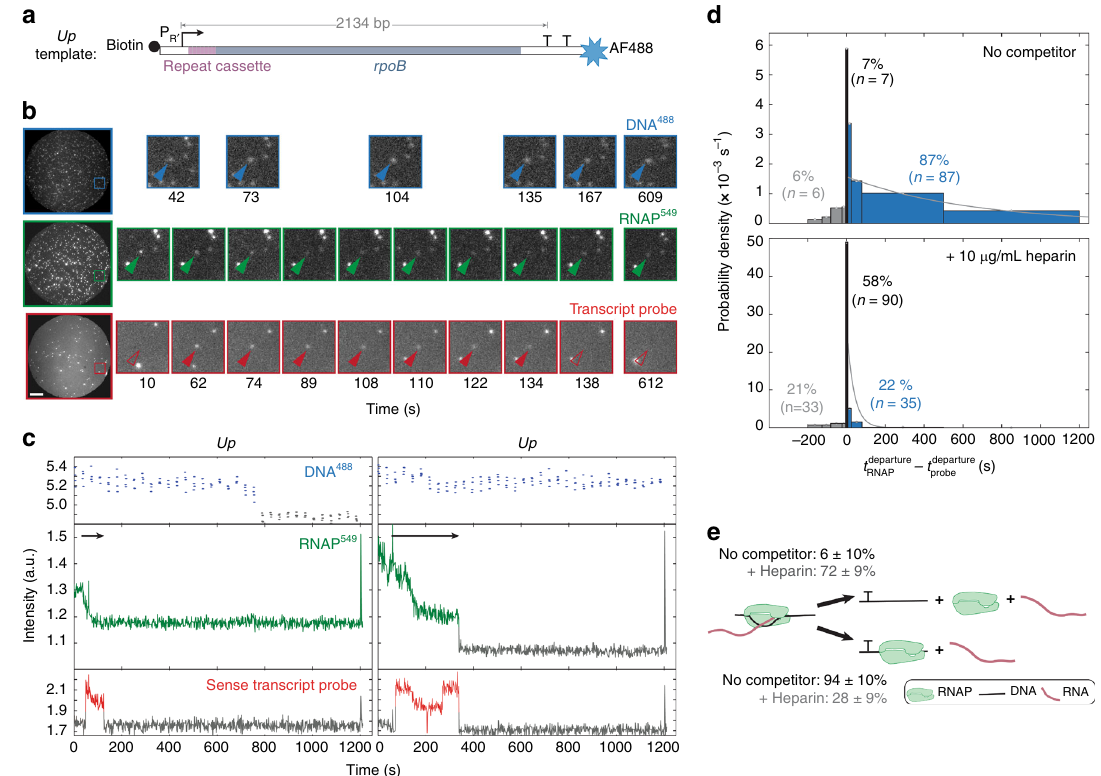
Fig. 1 RNAP usually remains bound to the DNA template following transcript release at an intrinsic terminator. a Up transcription template. The template contains a wild type λ P R´ promoter region (bent arrow) followed by seven tandem repeats of a 21 bp cassette (maroon), a partial sequence of E. coli rpoB coding region (gray) and two consecutive intrinsic terminators (T): λ T fi ciencies in vitro of 93-95% and R ʹ and T7 T E , which have termination ef 88 ± 2%, respectively 59 – 61 . Biotin is positioned upstream ( “ up ” ) of promoter so that RNAP moves away from the streptavidin-coated slide during transcription. b Left: Images (65 × 65 µ m) of the same microscope fi eld of view of DNA 488 (blue), RNAP 549 (green) and Cy5-transcript hybridization probe (red). Right: magni fi ed views of the marked regions at various times during the experiment; NTPs were introduced at time t ~ − 10 s. Blue arrows mark the location of a DNA spot, green and red arrows mark the surface location in the other images, with presence ( fi lled arrows) and absence (open arrows) of a co-localized fl uorescence spot indicated. Scale bar, 10 µ m. c Example fl uorescence emission records from the locations of two DNA spots from the same experiment. Gray color marks intervals during which no fl uorescent spot was seen. Arrows mark intervals of transcript elongation. Left: RNAP remains after probe departs (data from marked molecule in ( b )) Right: RNAP and probe depart simultaneously. d Normalized histogram of RNAP 549 departure time relative to Cy5-transcript probe departure from the same DNA spot for elongation reactions in the absence and presence of heparin. RNAP 549 spot departed either before (gray), within 4 s of (black), or after (blue) transcript probe spot departure. The 4 s threshold was chosen because it is the maximum interval between consecutive frames. Gray curves are single exponential fi ts to the RNAP departure times following probe departure (see the “ Methods ” section). e Reaction scheme indicating the fraction of terminating ECs for which RNAP 549 retains association with DNA after termination, calculated from the data in ( d